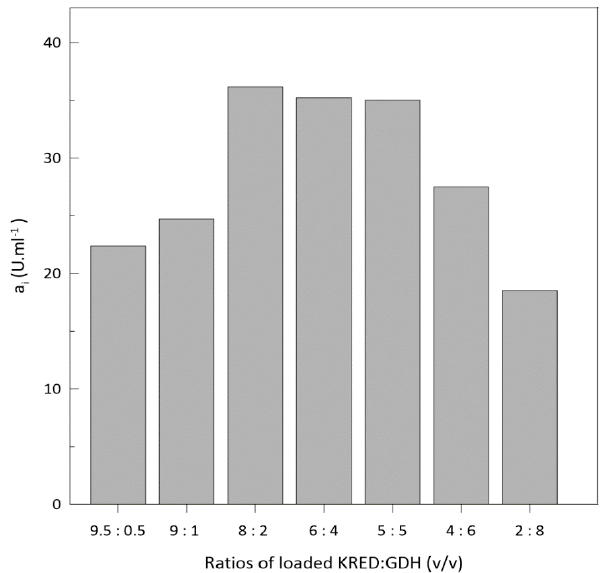
Figure 4. Activity of different enzymes’ loading ratio during immobilization.